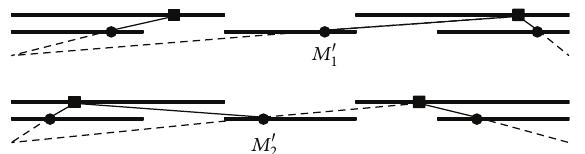
Figure 15: Scheme of conditions (62) (above) and (63) (below).